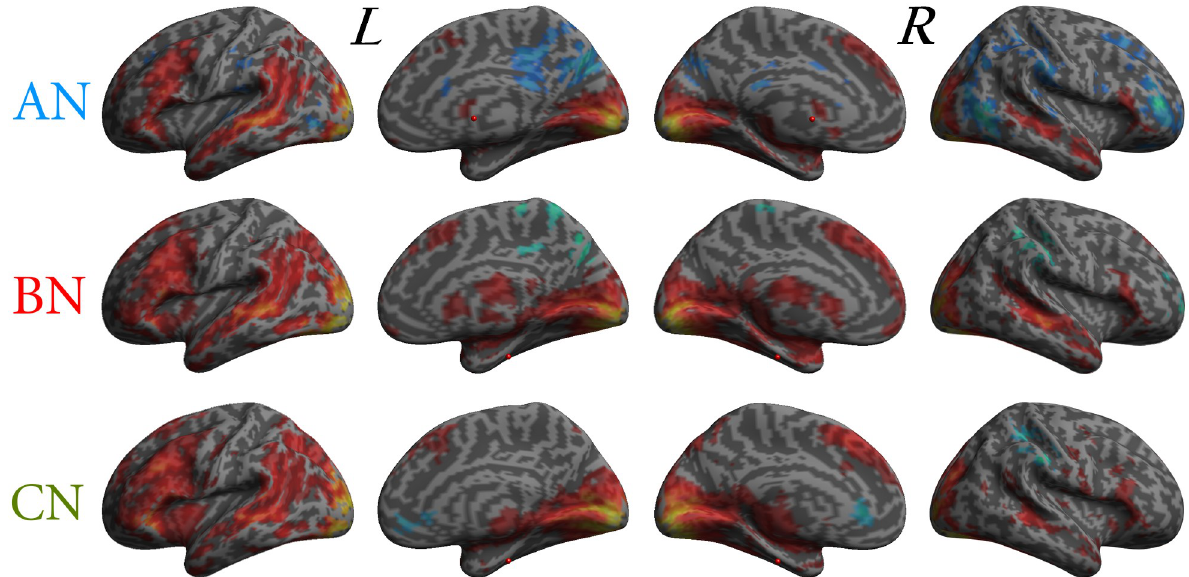
Fig 3. Results of the mean emotional activation and deactivations for the groups. AN = Anorexia Nervosa, BN = Bulimia Nervosa, CN = Normal Controls, L = left, R = right. In yellow-red significant mean activations for t contrast of all groups, in green-blue significant mean deactivations for t contrast of all groups depicted on an inflated 3D brain template (p < .05 FWEc). The shapes of the patterns were qualitatively very similar, but AN showed more extended deactivation, BN wider subcortical activations, CN had the more anterior cluster of deactivation along the midline structures.